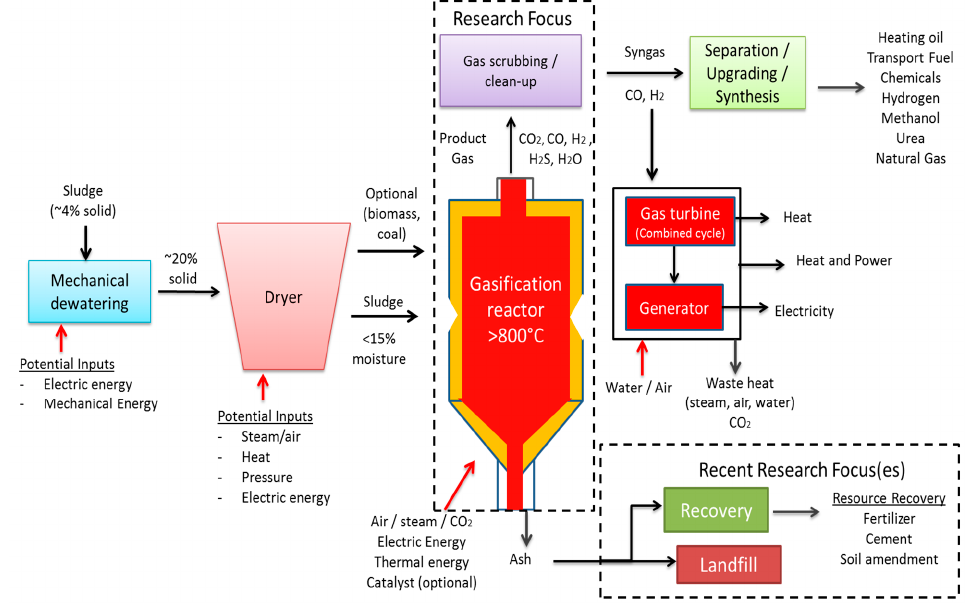
Figure 9. Schematic Representation of the Gasification of Sludge.